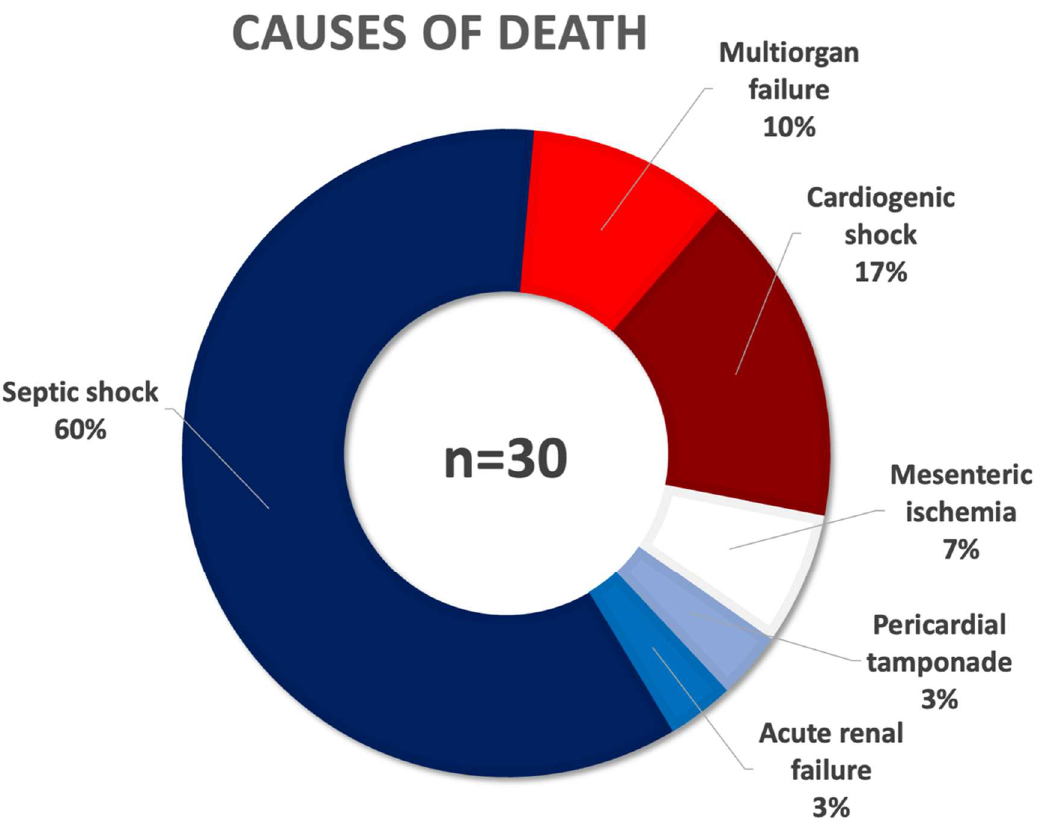
Figure 2. Ring chart showing the different causes of death in percent of all patient in-hospital deaths ( n = ( n = 30).